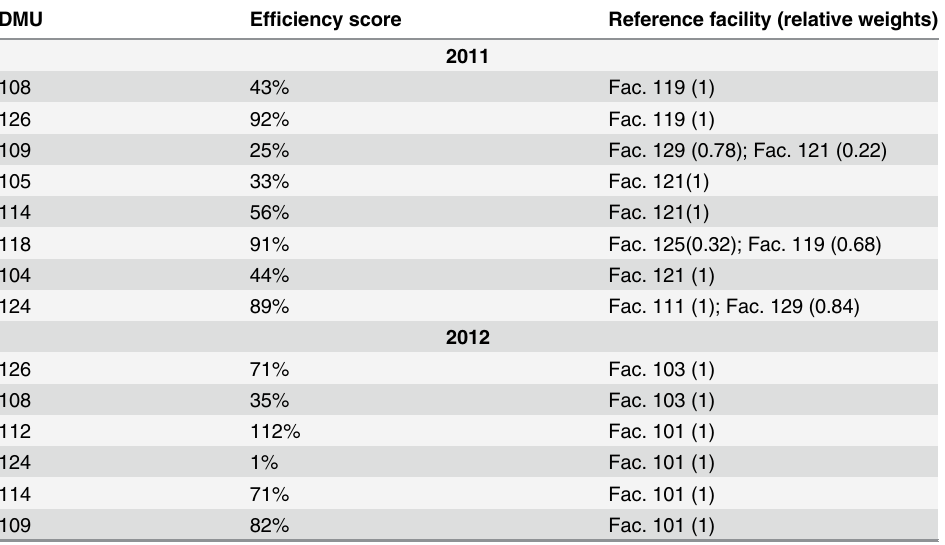
DMU = Decision-making unit; fac. = facility; Peer count/freq = number of times the facility is a peer (in